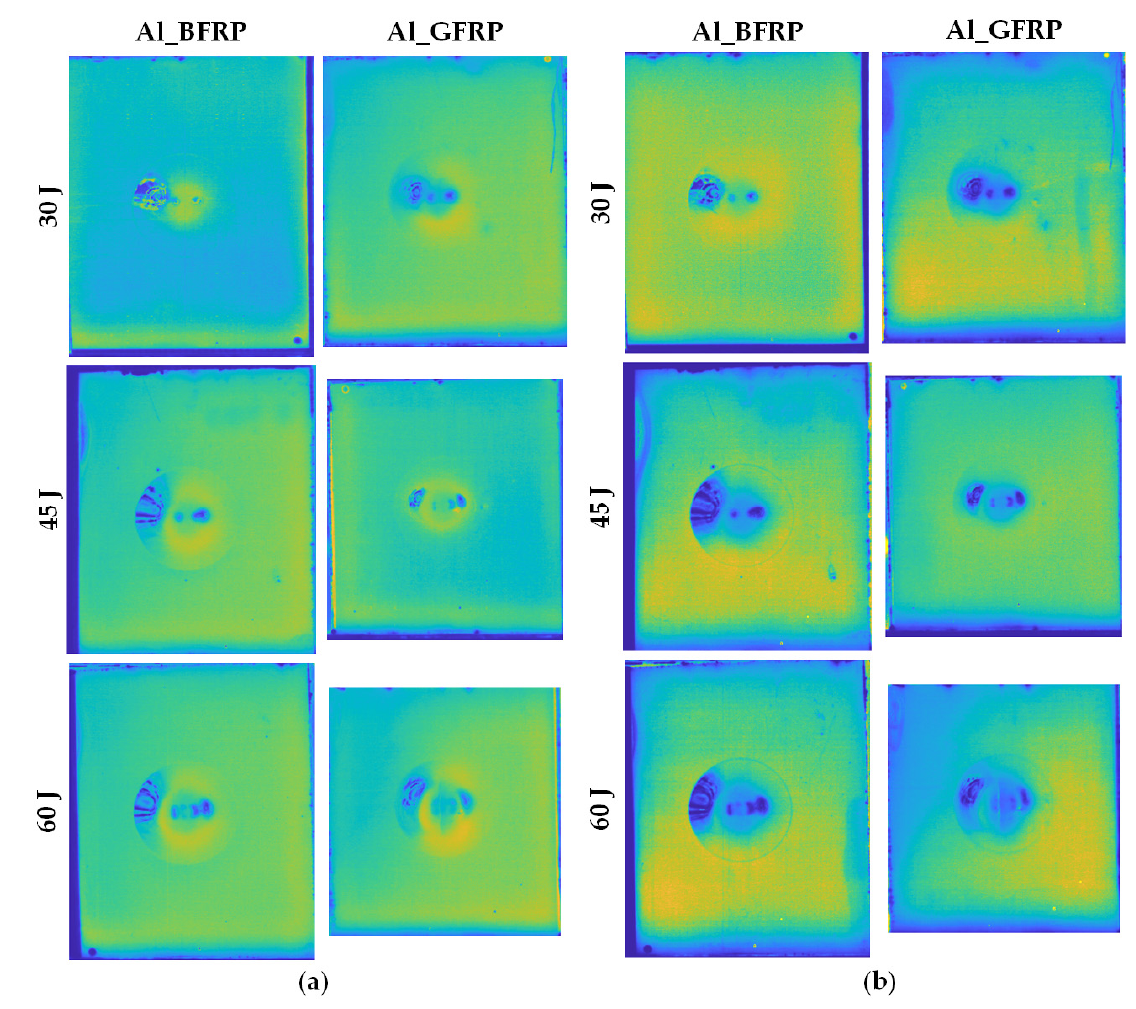
Figure 9. Statistical features of the PT experiments on six samples: ( a ) skewness features; ( b ) kurtosis features.